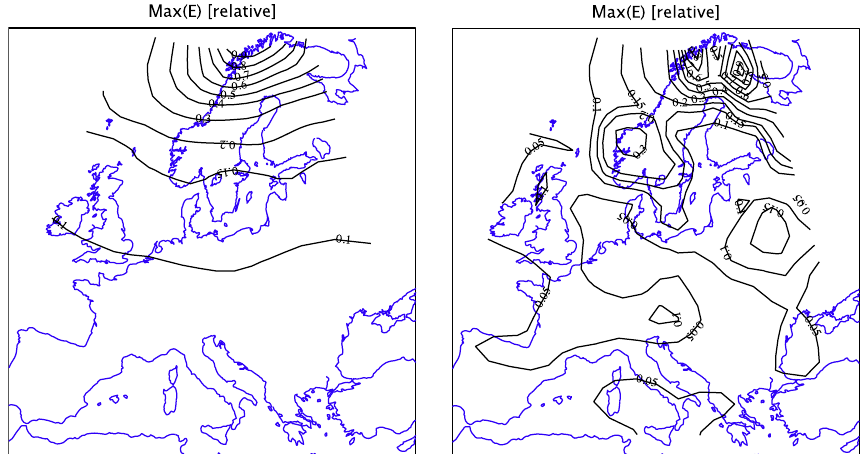
Fig. 3. Left: median of the daily maximum values of the electric field in 1996–2008 using the conductivity Model 01 of Table 1 and a regular surface grid covering the area in Figure 2. Right: as in the left, but using the full conductivity map shown in Figure 2. In both plots, the largest value is normalized to unity.